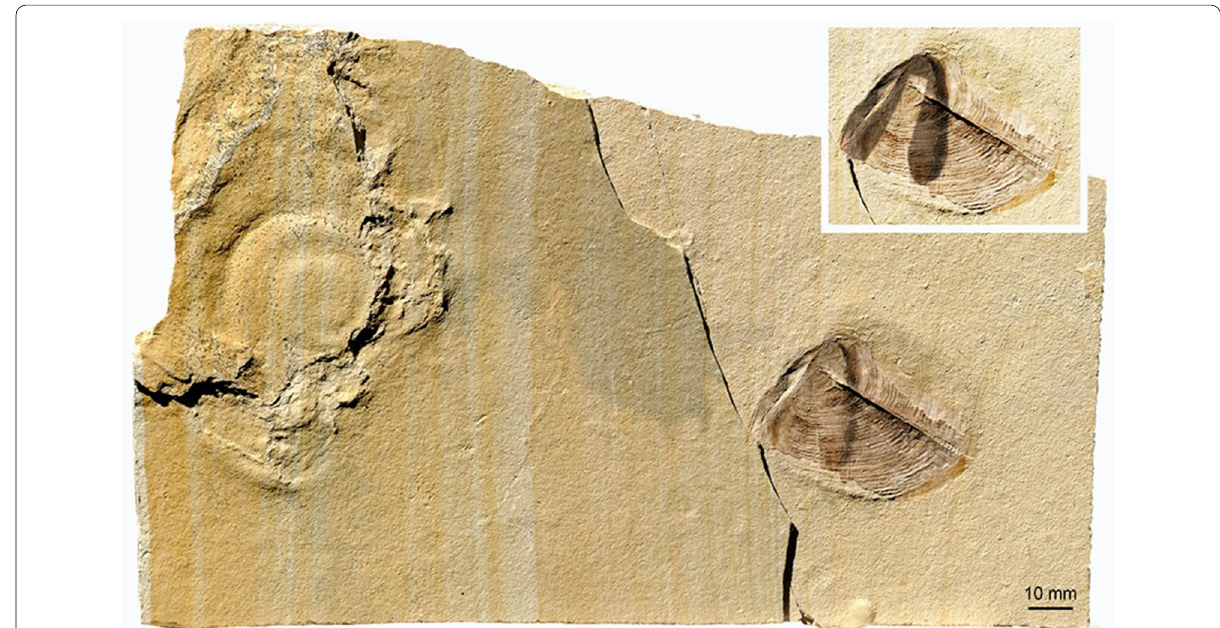
Fig. 5 Fragmentary conch of a perisphinctid with complete jaw apparatus ( Praestriaptychus ) next to it from the late Kimmeridgian of Nusplingen (SMNS 70613). The facts that upper and lower jaws are still in contact (insert with modified brightness to show the arrangement of the upper jaw), that the buccal mass is so close to the damaged conch that all parts likely belonged to the same species, and the dark stain between these parts suggest that they were parts of the same